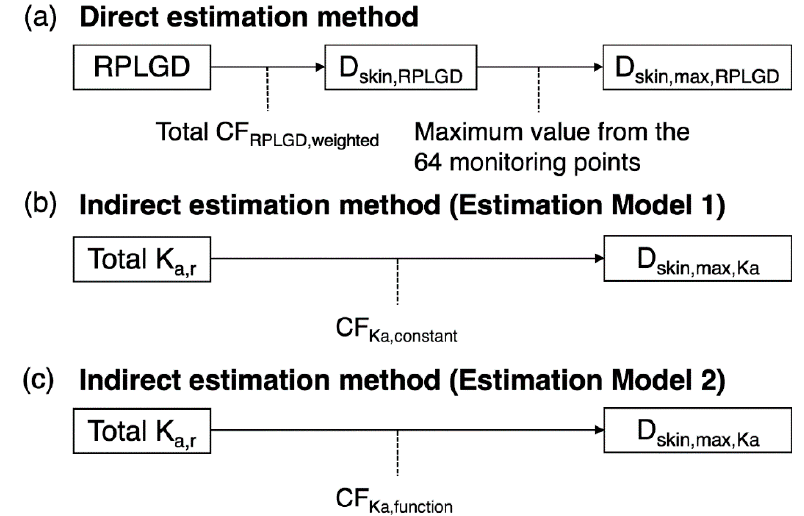
Scheme 1. Schema of the methods used for estimating the maximum skin dose (D skin,max ) in